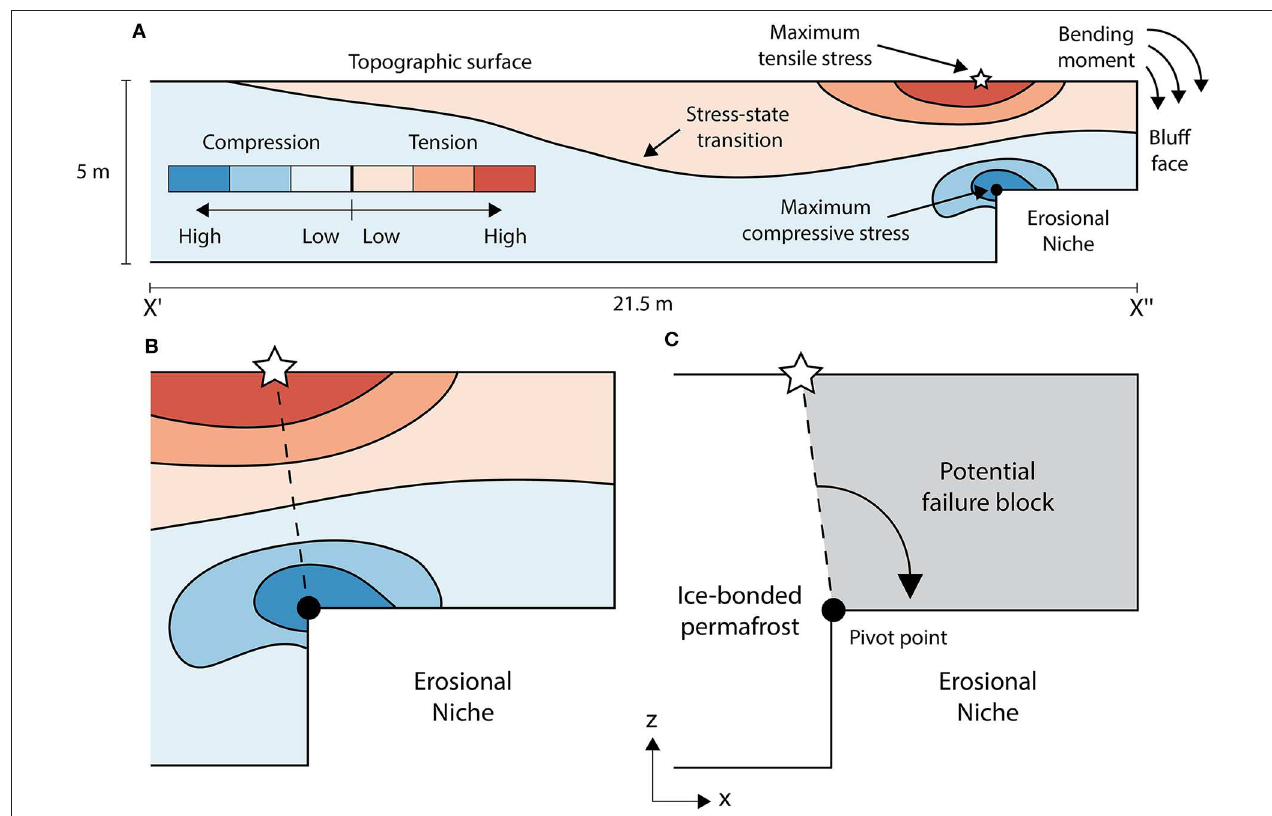
FIGURE 4 | (A) Conceptual cross section (X ′ -X ′′ in Figure 3 ) of patterns of stress based on elastic geomechanical simulation. (B) Enlargement of stress field in the vicinity of the bluff face and erosional niche. Dashed black line connects the points of maximum tensile and compressive stress. (C) Diagram of potential toppling mode block failure (gray area) about a pivot point (black